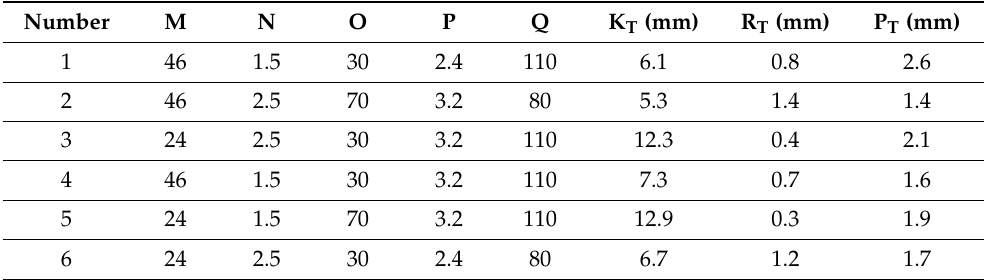
Table 6. Experimental design and weld bead size for TIG